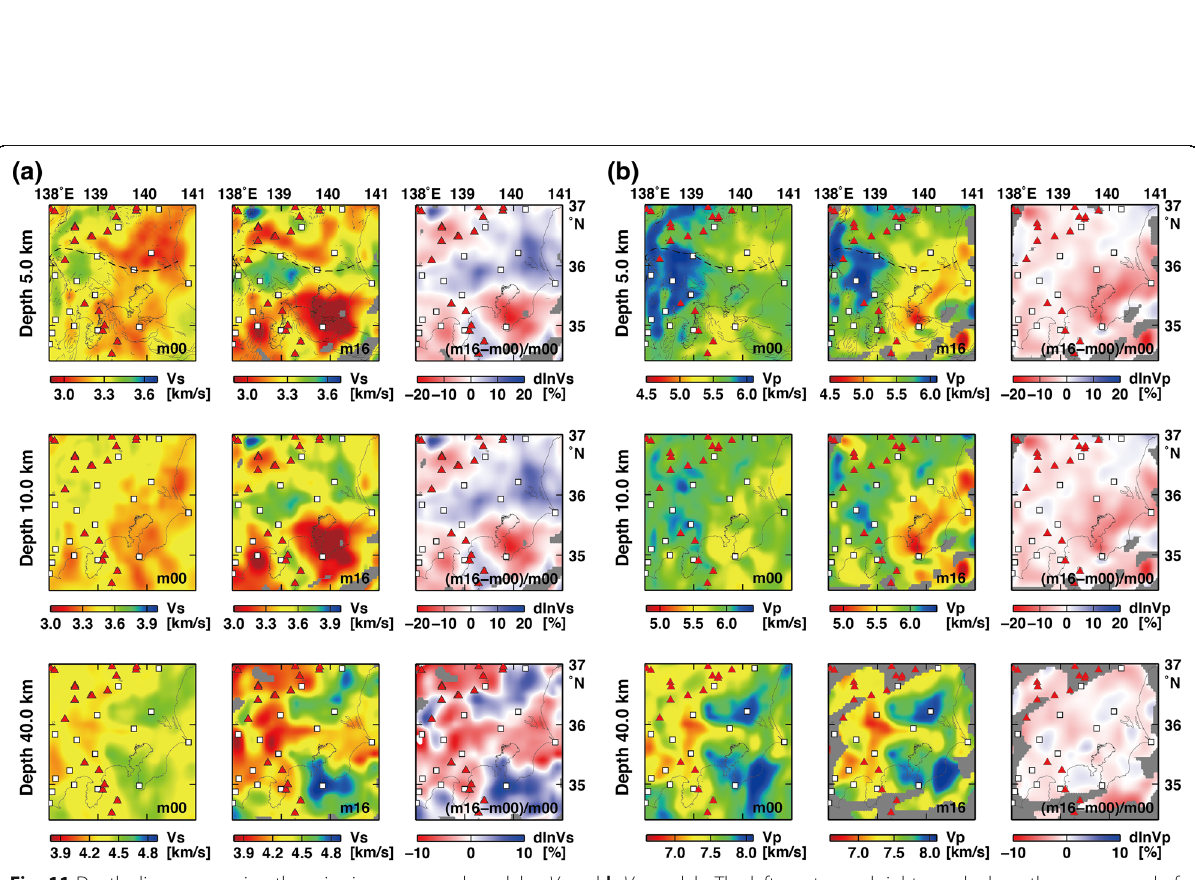
Fig. 10 Results of seismic wave speed changes. a Average wave speed of V s and V p concerning depth. Black and red lines indicate m 00 and m 16 , respectively. b Comparison of V s values of m 00 and m 16 . c Comparison of V p values of m 00 and m 16